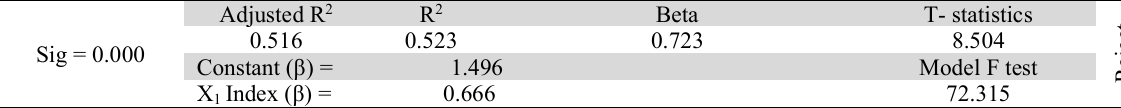
The results of examining the second